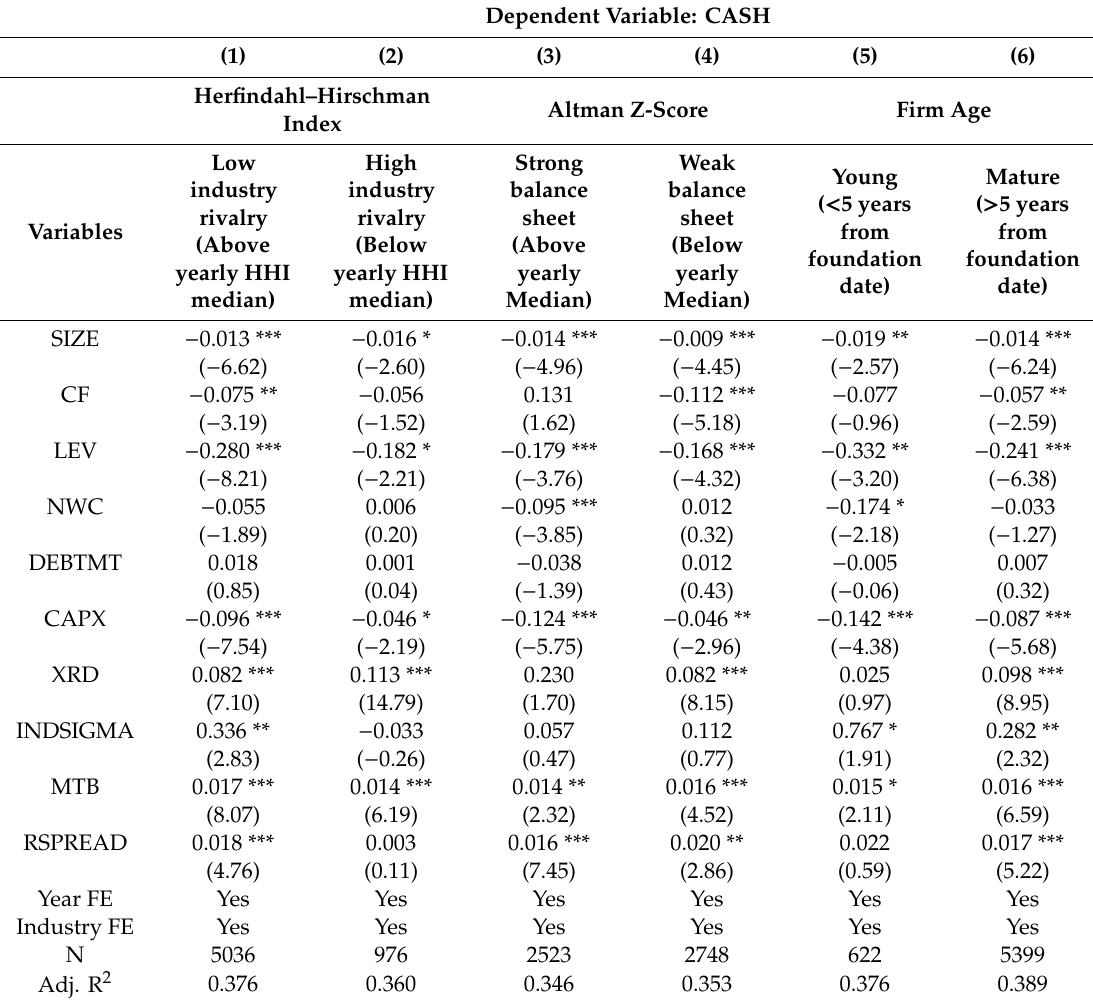
Table 9. Regression results of firm characteristics on cash to total assets (CASH) based on di ff erent levels of competition, financial distress, and firm’s